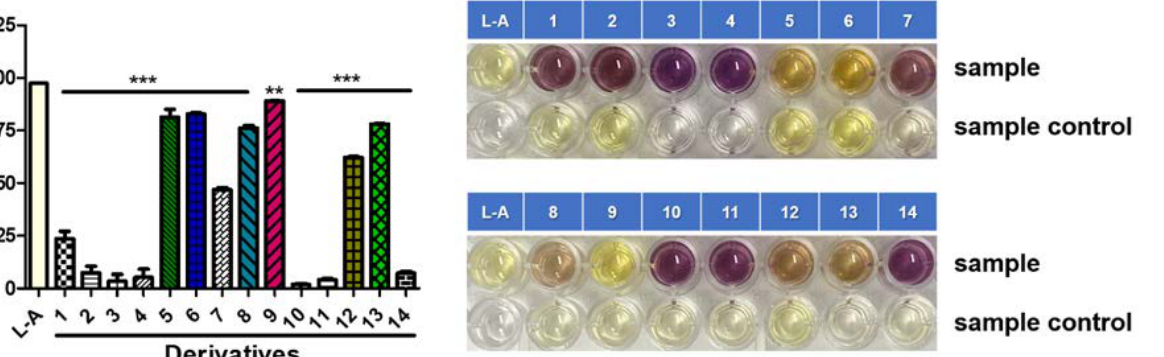
Figure 10. Radical scavenging activities of BABT derivatives 1 – 14 determined using a 2,2-diphenyl-1-picrylhydrazyl (DPPH) assay. BABT derivatives 1 – 14 and L -ascorbic acid (L-A), the positive reference control, were used at a concentration of 500 µ M. The optical densities of the test samples mixed with 0.18 mM DPPH radical solution were measured at 517 nm after keeping the mixed sample solution in the dark for 30 min. An asterisk symbol (*) indicates significant differences between BABT derivatives and L -ascorbic acid. Results are represented as the mean ± SEM of three independent